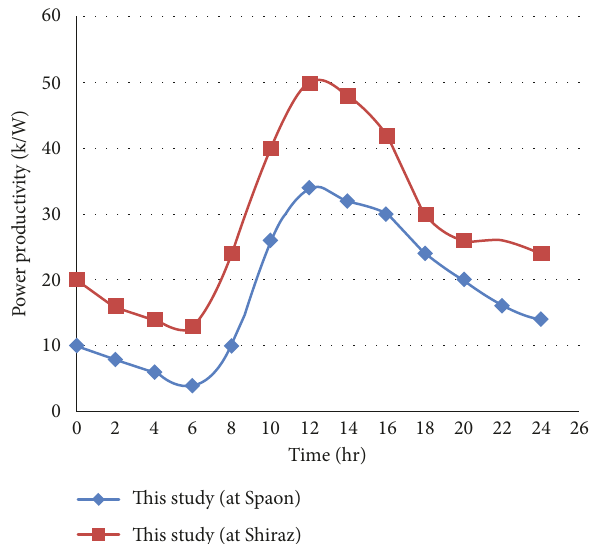
Figure 5: Comparison of power production in Shiraz and Manzanares cities on September